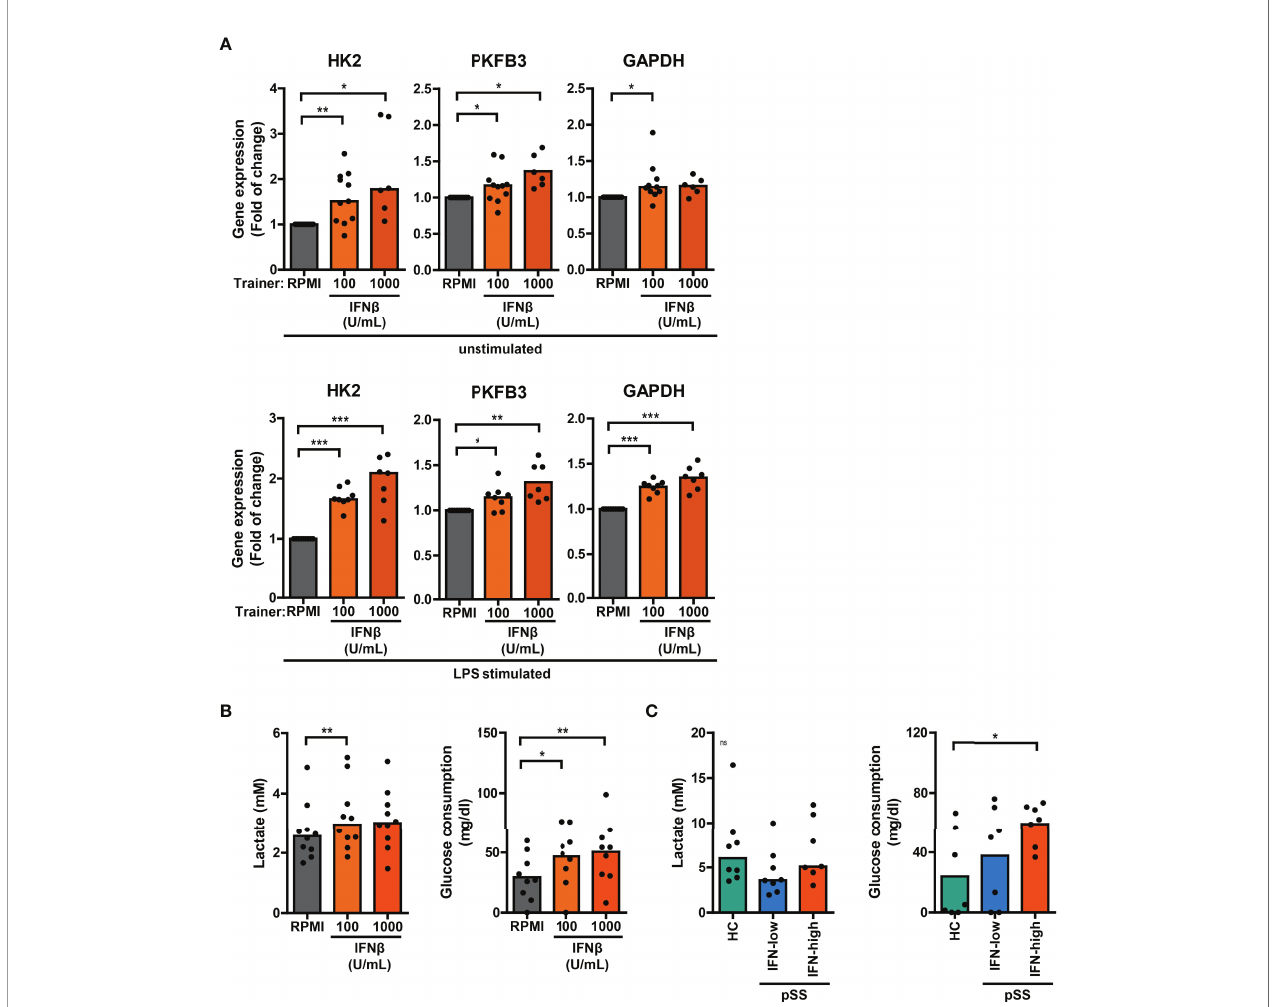
FIGURE 6 | Altered glucose metabolism in type I IFN-trained THP-1 and patient ’ s PBMCs. (A) Relative mRNA expression (2 DD CT ) of HK2 , PKFB3 and GAPDH in THP-1 cells trained with IFN b either before re-stimulation (upper panel) or after 24 hour stimulation with 50 ng/mL LPS (lower panel). Fold change expression was calculated relative to the corresponding untrained (RPMI) cells. (B, C) Lactate concentrations (left) in culture supernatants and glucose consumption (right) by 24 hour LPS-stimulated (B) THP-1 cells trained with IFN b or (C) PBMCs from pSS and HC. One sample t-test or Wilxocon singed rank test were used to compare means/ medians with a hypothetical 1 and repeated measures ANOVA or Friedman test, or Kruskal-Wallis test was used to compare groups. ns: not signi fi cant, *p<0.05, **p<0.01,